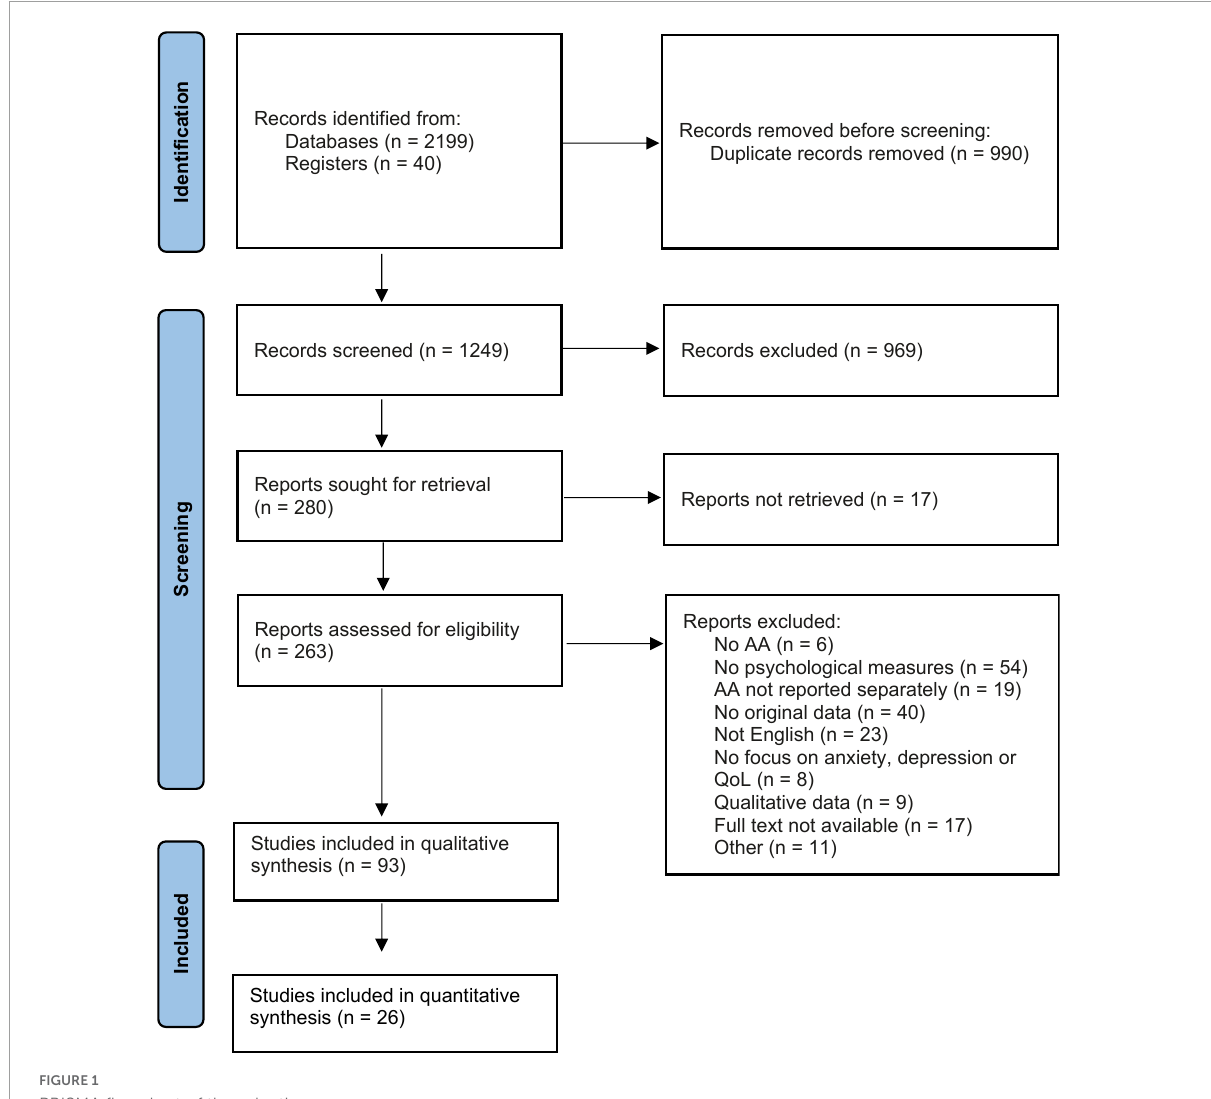
FIGURE1 PRISMA flowchart of the selection process.